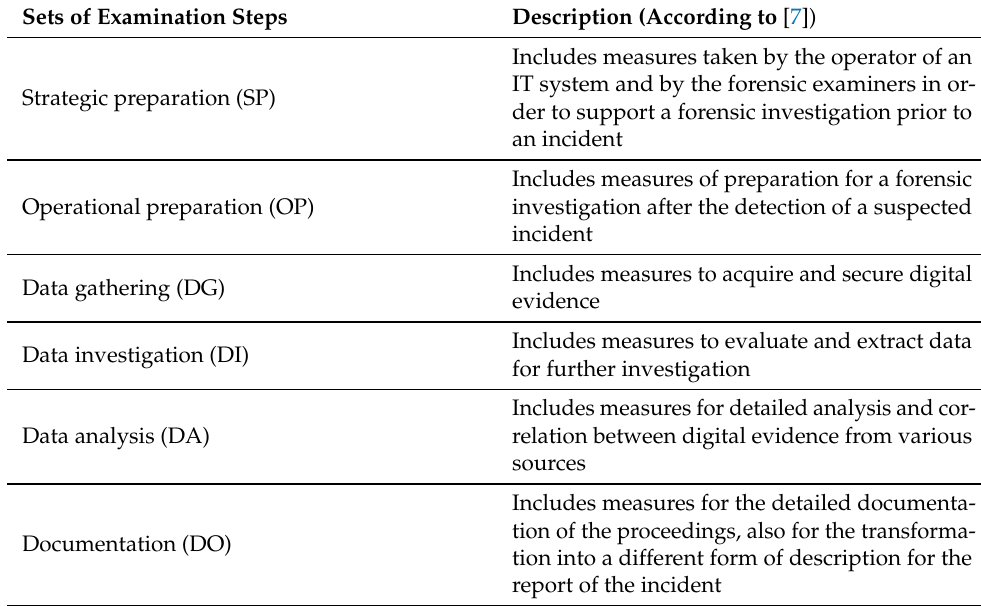
Table 1. Sets of examination steps for digital forensics, as defined in [7] (updated from [32])